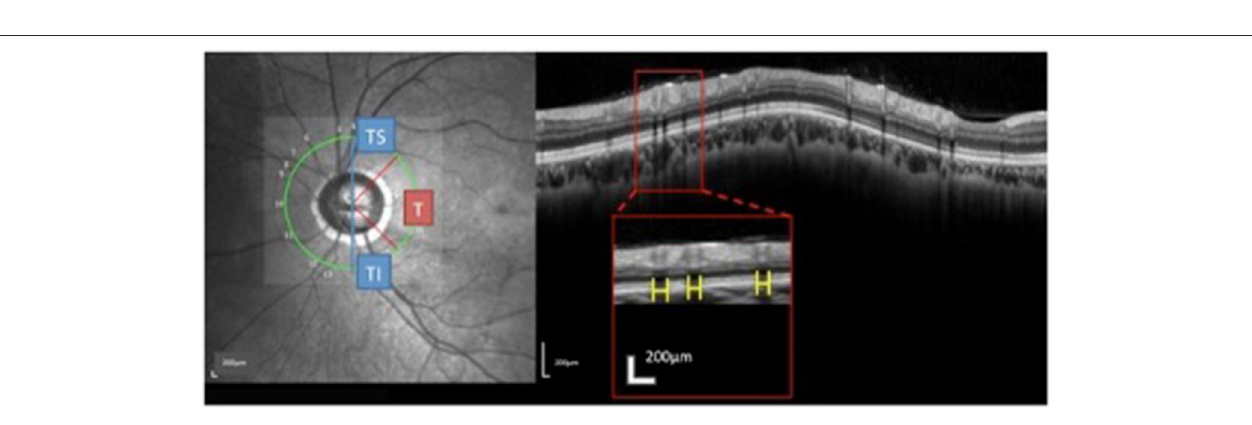
enrolled POAG patients used only one antiglaucoma medication, a prostaglandin analog. The sex and age distributions and other characteristics of both groups were similar ( Table 1